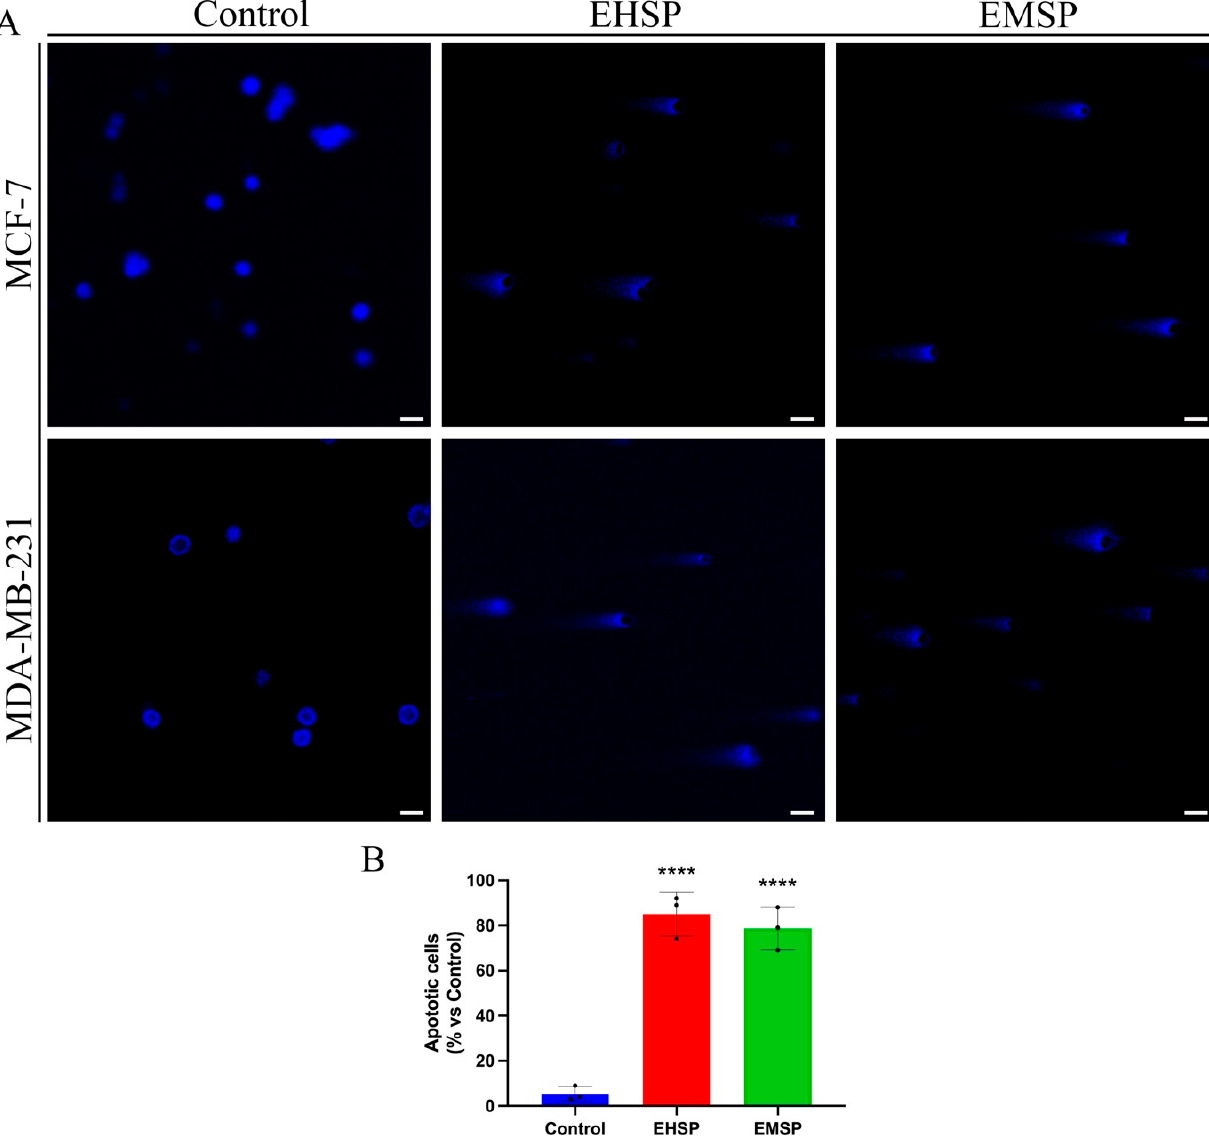
Figure 2. ( A ) Comet assay of MCF-7 and MDA-MB-231 cells treated with EHSP or EMSP at their IC 50 values, or with the vehicle alone (Control) for 3 days. 4 ′ ,6-Diamidino-2-phenylindole dihydrochloride,2-(4-Amidinophenyl)-6-indolecarbamidine dihydrochloride (DAPI) was used to stain nuclei. Pictures were obtained at 20×. Scale bar 25 μ m. ( B ) Apoptotic cells quantification. Values represent means ± SD from three independent experiments ( n = 3). Statistical analysis was performed using one-way ANOVA analysis. **** p < 0.0001.